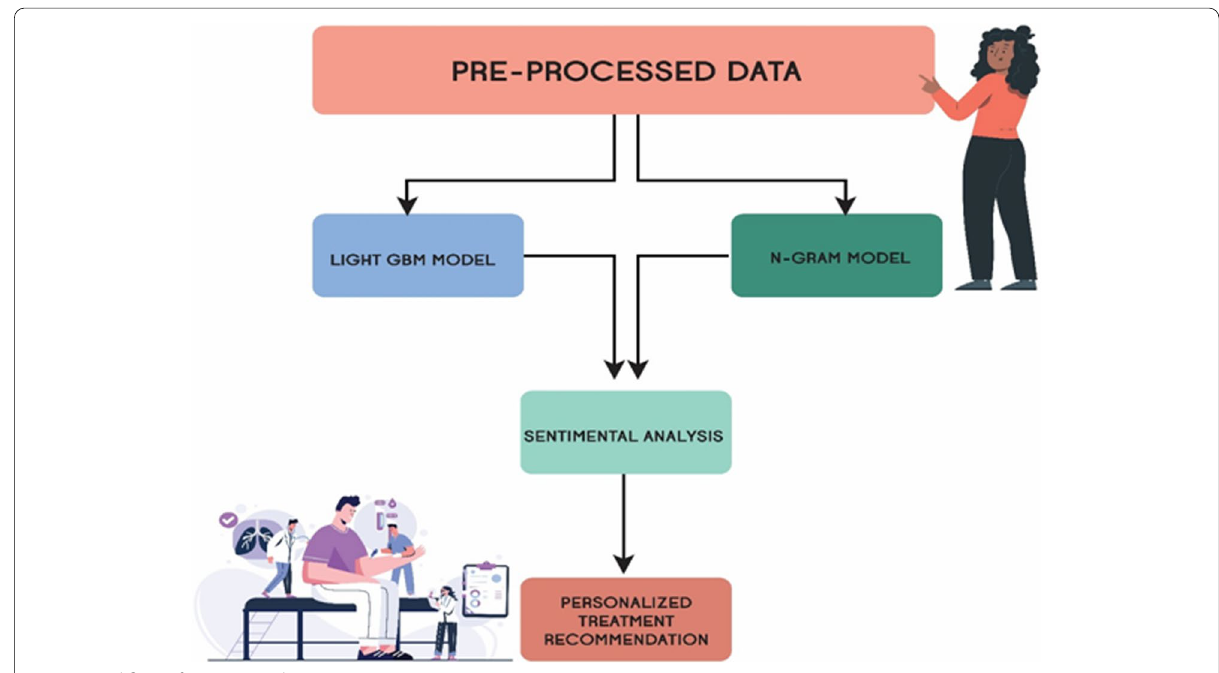
Fig. 5 Workflow of recommendation system